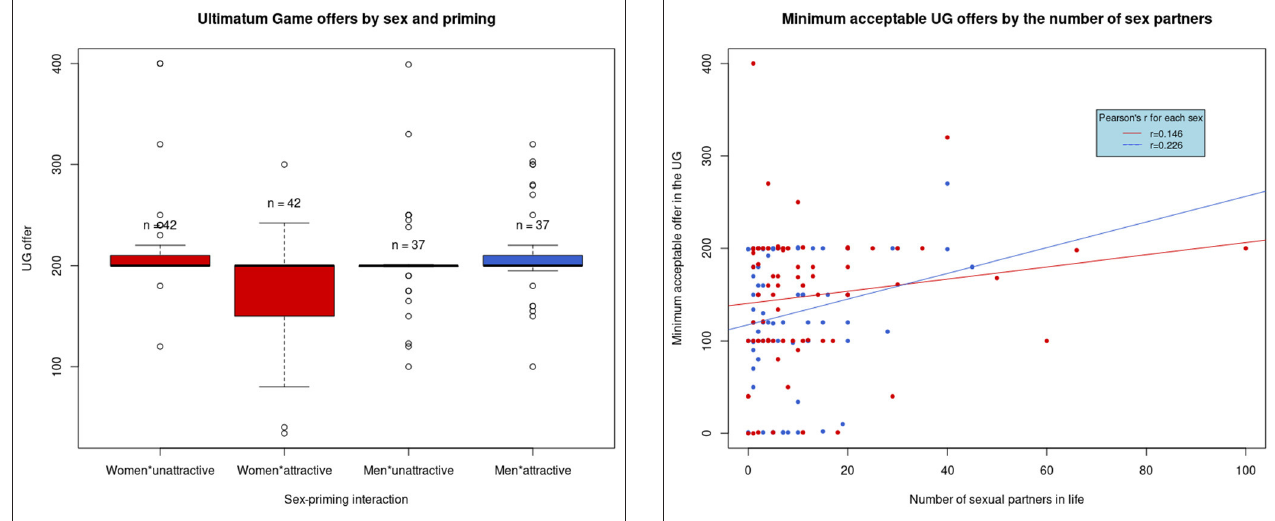
FIGURE 2 | Minimum acceptable offer (MAO) in the UG by the number of sexual partners in life. Women are shown in red and men in blue. The regression line for each sex is displayed, and the rectangle shows Pearson’s r for each